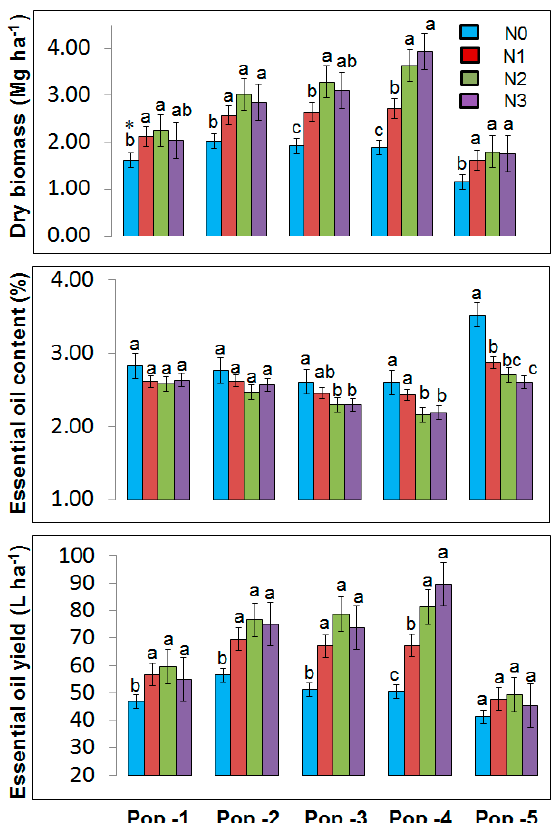
Figure 3. Mean values for (a) dry biomass production (Mg ha − 1 ), (b) essential oil content (mL 100 g − 1 DW) and (c) essential oil yield (L ha − 1 ) for each of the oregano populations (1-Panagia, 2-Litochoro, 3-Omolio, 4-Papadates, 5-Vytina), averaged for the three cultivation years, with respect to each of the nitrogen fertilization levels (control, N1, N2, N3, that correspond to 0, 40, 80 and 120 kg N ha − 1 , respectively). * For each population mean values ( ± S.E.) followed by different letters are significantly different at p <